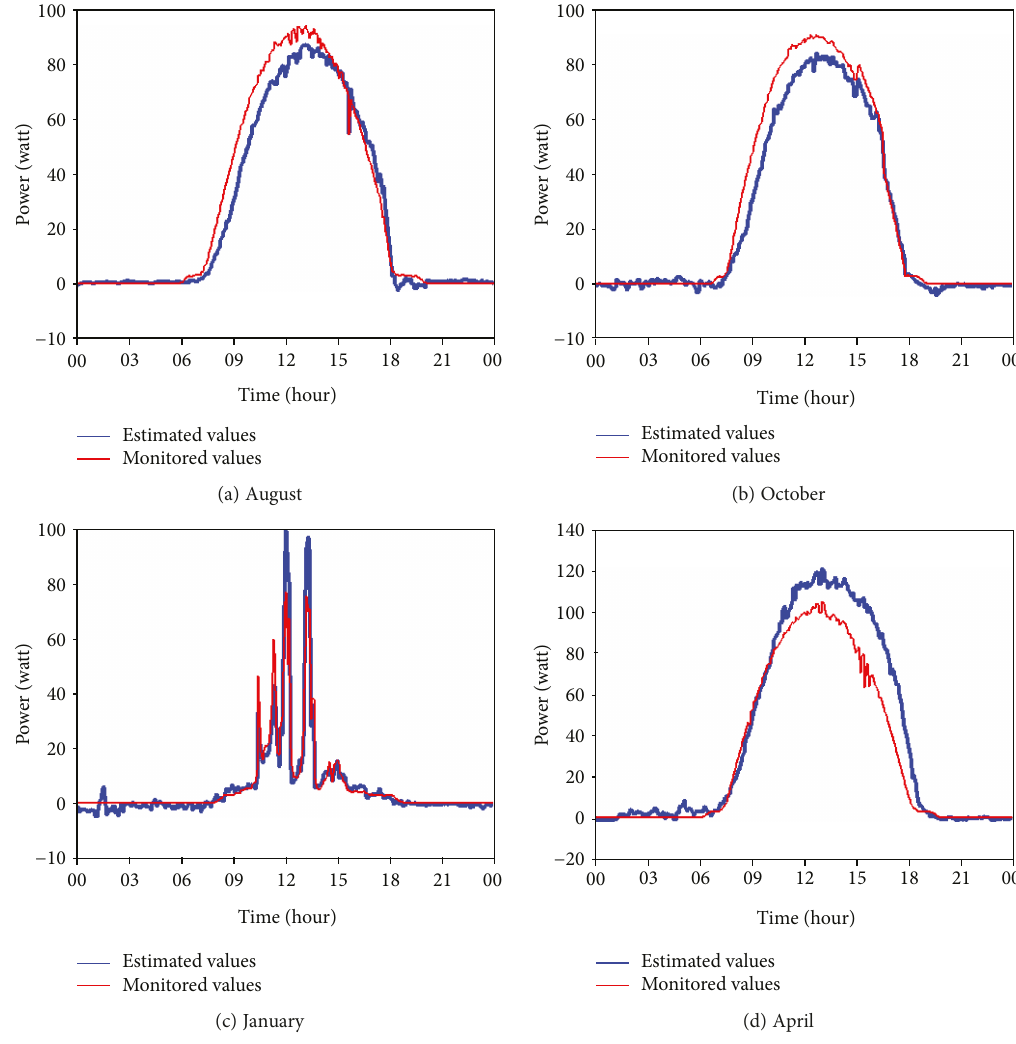
Figure 8: Sample estimation graphs for